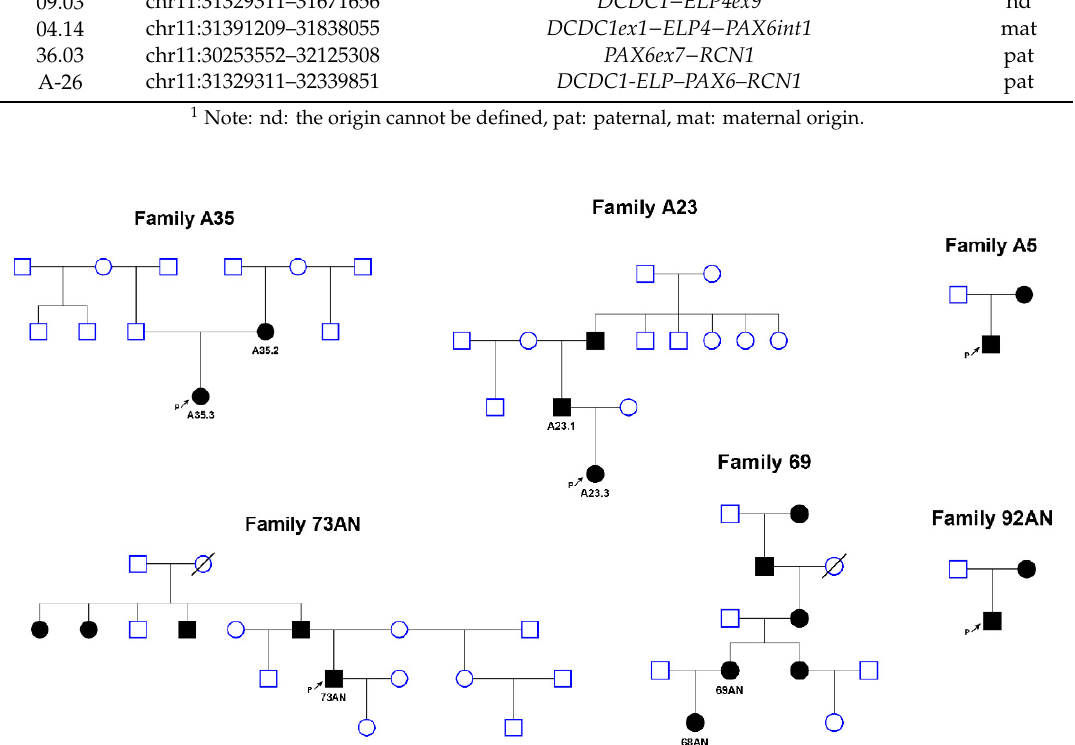
3 of 7 Table 1. Patients with de novo deletions of 11p13 region. Patient’s ID